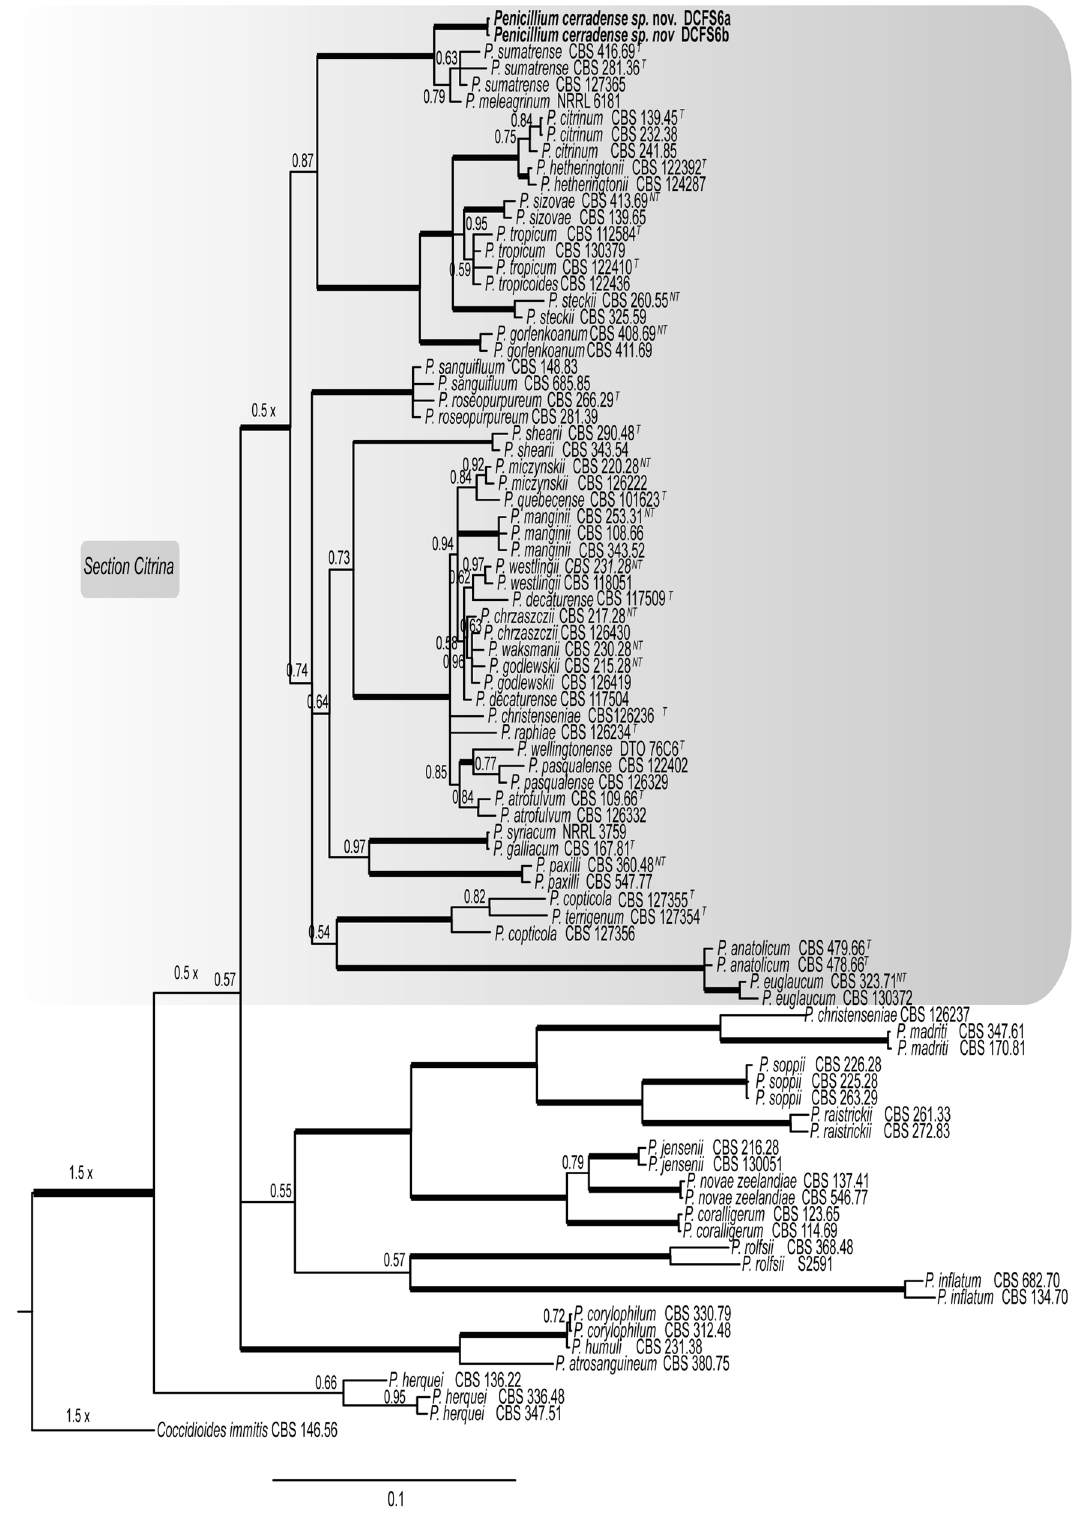
Figure 1. Bayesian phylogenetic tree based on concatenate sequences (ITS and RPB2) of Penicillium species section Citrina . Bayesian posterior probabilities values are indicated at the nodes and thick lines indicate posterior probability greater than or equal to 0.99. The isolates in this study are highlighted in bold. The tree was rooted with Coccidioides immitis CBS 14656. The specimens in this study are highlighted in